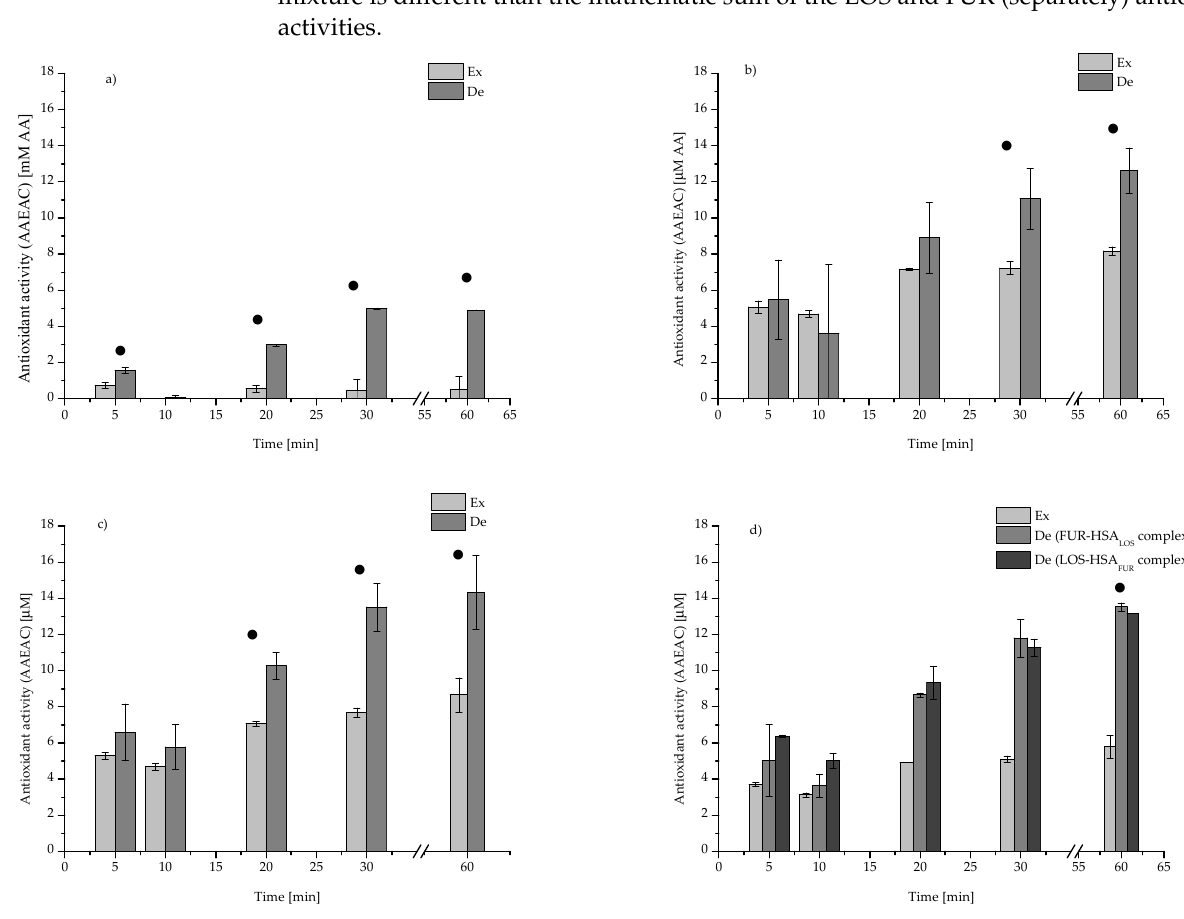
Figure 6. Expected versus designated values of antioxidant activity (AAEAC) of samples ( a ) LOS- FUR, ( b ) LOS-HSA ( c ) FUR-HSA, ( d ) FUR-HSA LOS and LOS-HSA FUR (DPPH assay); • —statistically significant difference. Table 6. The Total Antioxidant Capacity (AAEAC) (ABTS assay).